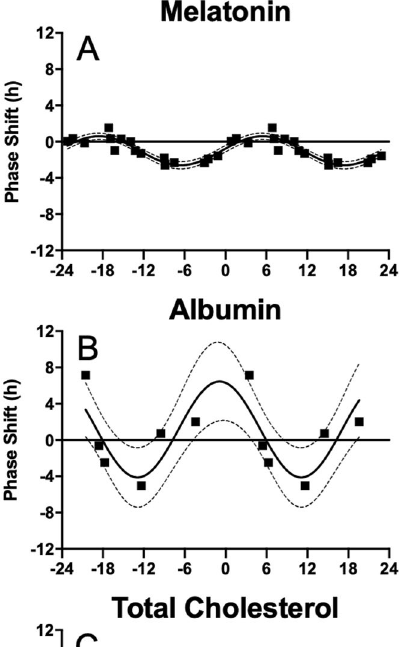
Fig. 3 Phase response curves (PRCs). Raw phase shifts in ( A ) melatonin, ( B ) albumin, ( C ) total cholesterol, ( D ) triglycerides, and ( E ) HDL-C plotted as a function of circadian phase of the stimulus, de fi ned as the onset of LE - CR1 assay-speci fi c acrophase. PRCs are double-plotted. The solid horizontal black line indicates no phase shift. Black squares represent each individual that had statistically signi fi cant cosinor regressions in the assay during both CR1 and CR2. The solid sinusoidal black line is the fi tted single-harmonic function. The 95% con fi dence intervals generated from the fi t single- harmonic function are shown by the grey dotted